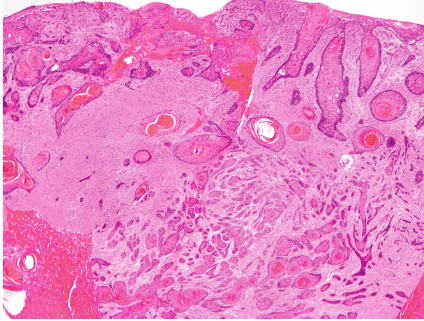
Figure 3: Histopathologic examination with hematoxylin-eosin staining showed epidermal erosion and irregular nests and cords of dysplastic keratinocytes infiltrating the